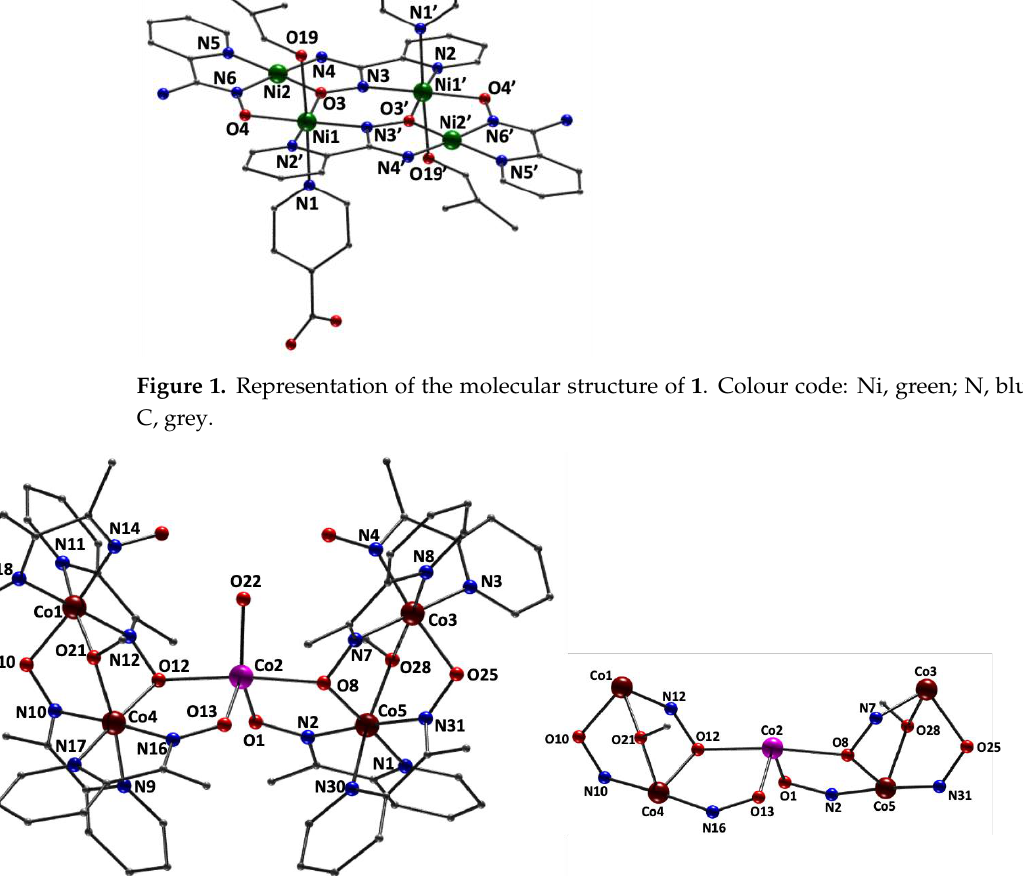
Figure 2. Representation of the molecular structure of 2 ( left ) and the bowtie metal topology of its structural core ( right ). Colour code: Co II , pink; Co III , dark red; N, blue; O, red; C, grey.